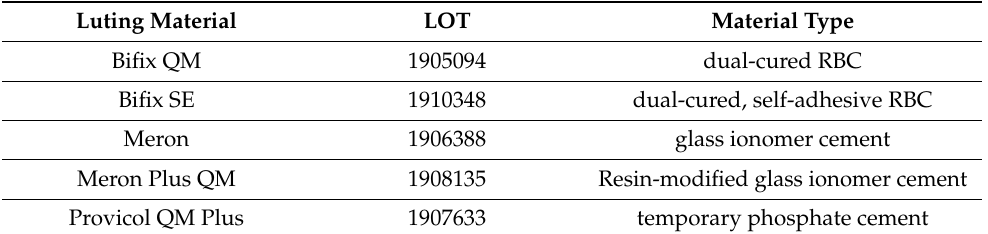
Table 1. Analyzed luting materials: product name, batch number, and material type. All analyzed luting materials were manufactured by the company VOCO (Cuxhaven,